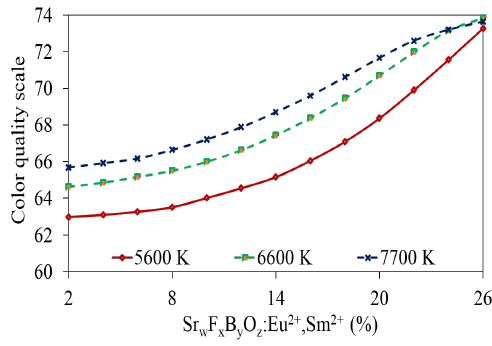
Fig. 4: The color quality scale of WLEDs as a function of Sr w F x B y O z :Eu 2+ , Sm 2+